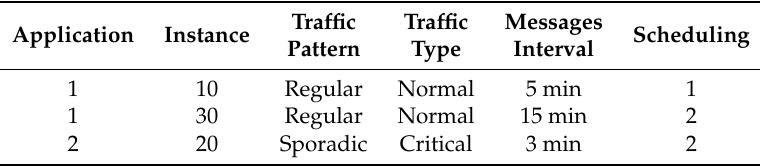
Table 3. Scheduling for DYNASTI in scenarios varying the number of